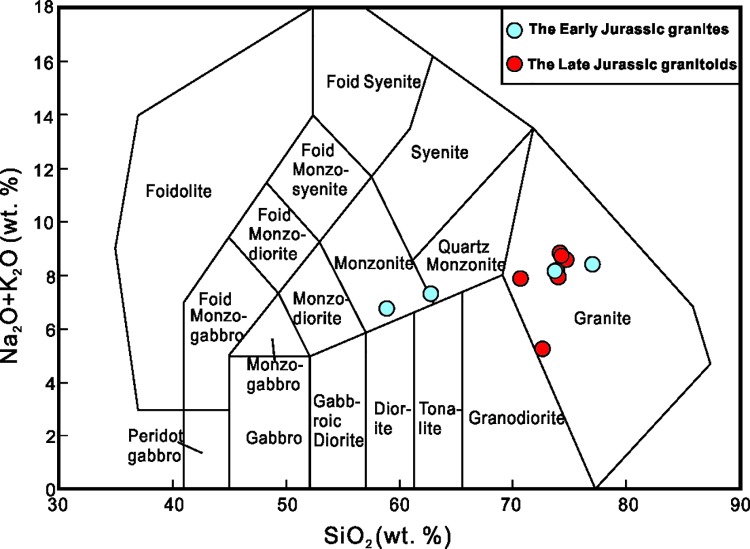
SiO2-(K2O+Na2O) (TAS) Diagram showing samples from the NIC (after [47]).